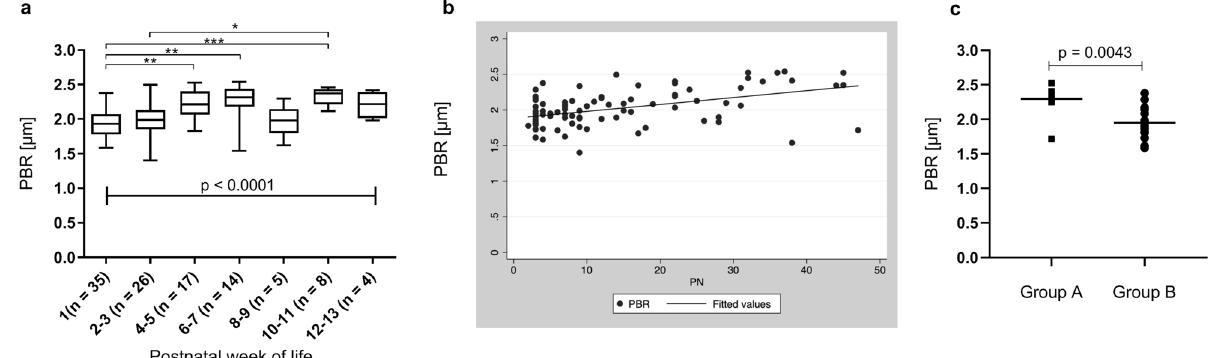
Figure 4. ( a ) PBR values obtained during longitudinal follow up of preterm neonates grouped according to postnatal age at measurement. ( b ) Linear mixed-effects model showing association of PBR and postnatal days (PN) per group. ( c ) Comparison of PBR values obtained in extremely premature neonates (Group A) when reaching a corrected gestational age > 30 + 0 weeks and PBR values in moderately preterm neonates (Group B) measured after birth. *p < 0.05, **p < 0.01, *p <